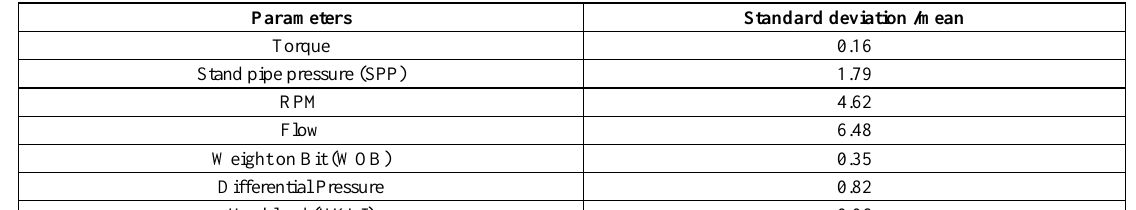
Table 2. High variance curves